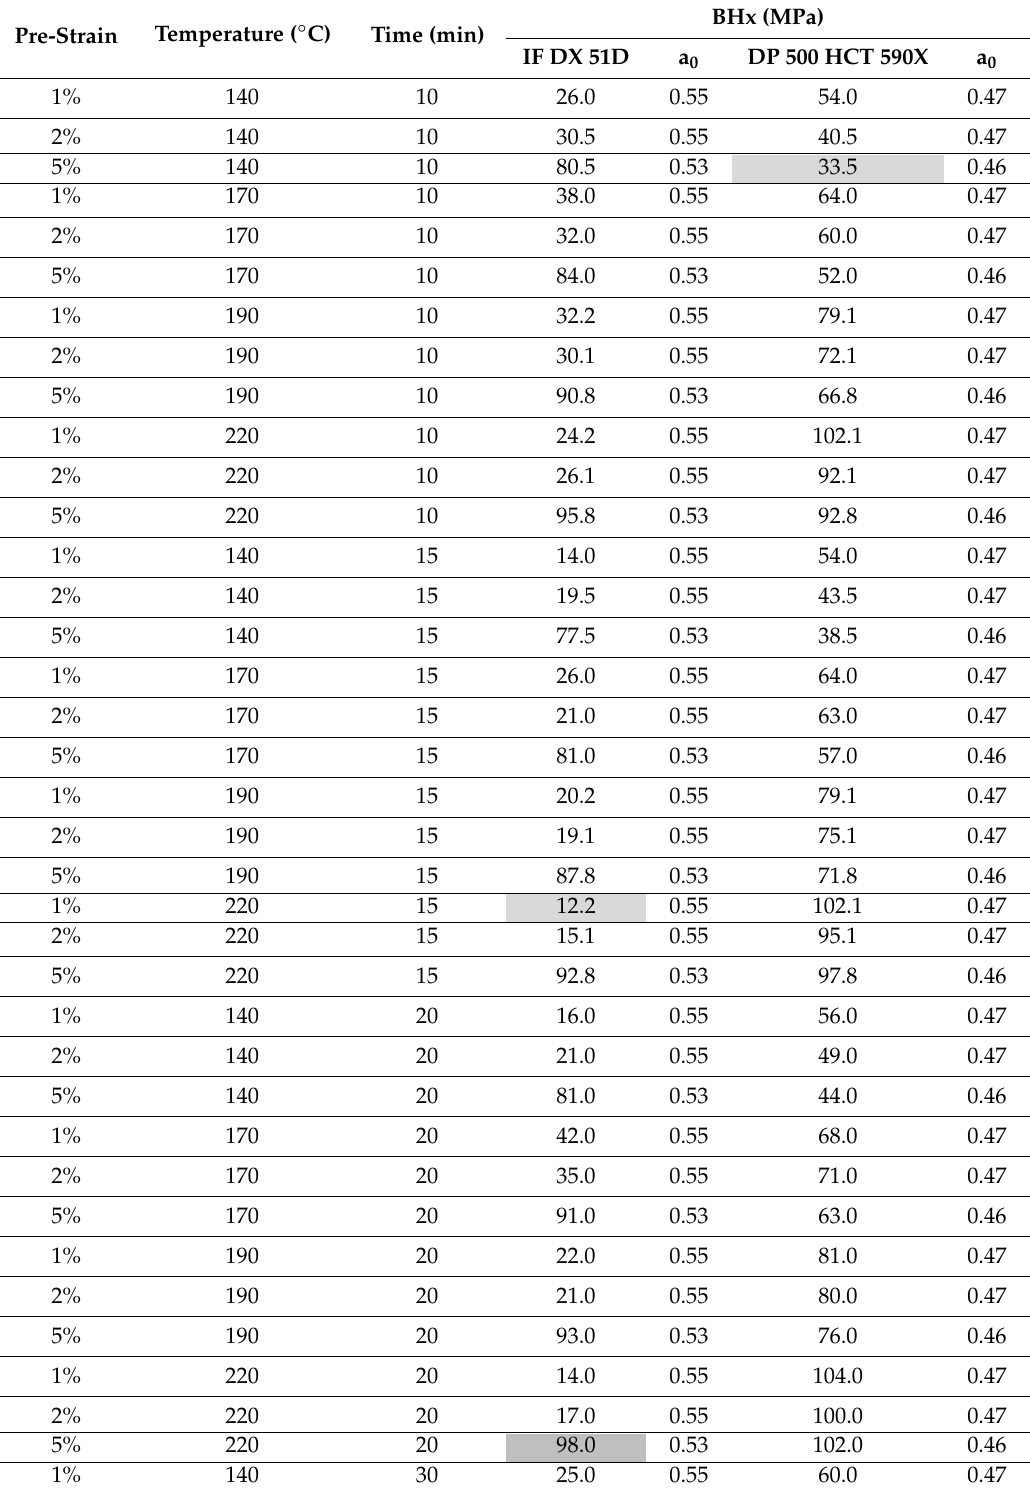
Table A1. Measured values of BH